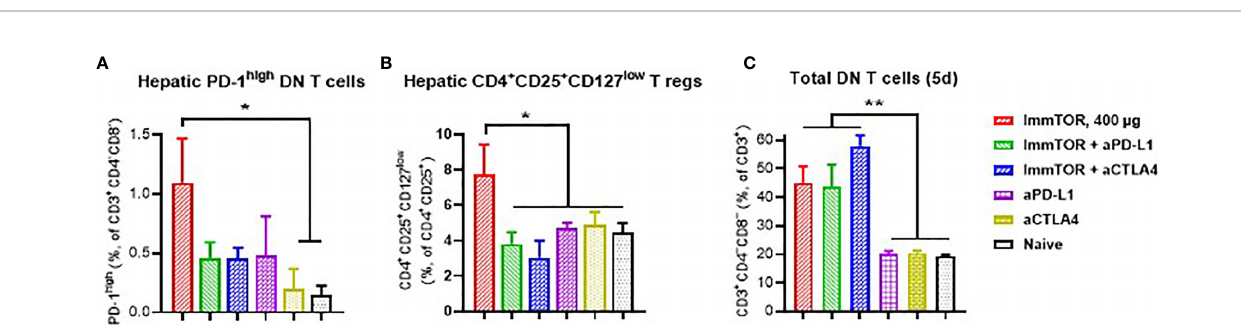
FIGURE 6 | Effect of anti-PD-L1 and anti-CTLA-4 antibodies on ImmTOR-driven changes in hepatic T cells. Hepatic T cells were analyzed by fl ow cytometry 7 days after treatment with ImmTOR alone (400 µg), anti-PD-L1 or anti-CTLA-4 antibodies (i.p., 100 µg, three times with 3d intervals starting 3 days prior to ImmTOR injection), or ImmTOR combined with anti-PD-L1 or anti-CTLA-4 antibodies. Fractions of PD-1high DN T cells (A) , regulatory T cells (B) , and DN T cells (C) , are shown. Representative results of individual study repeated at least twice is shown (n=3 mice/group). Statistical difference in the size of respective fractions from ImmTOR-treated animals vs. other treatments is shown (* – p<0.05, ** – p<0.01; unpaired t-test).